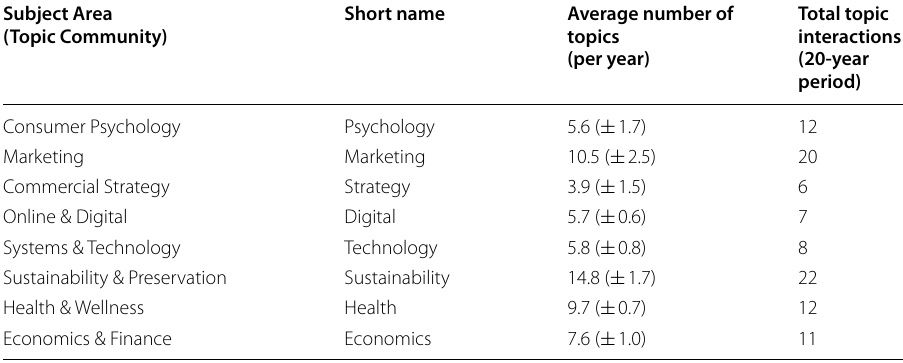
Table 3 Primary subject areas of consumer behavior research Subject Area (Topic